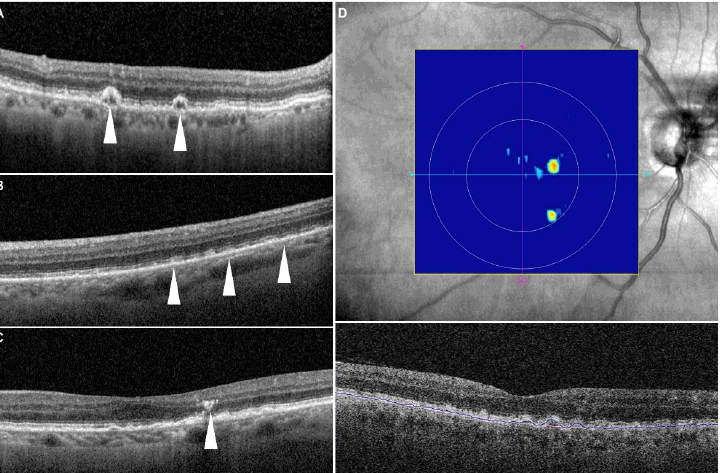
Figure 1. Representative examples of structural optical coherence tomography risk factors. ( A ) Representative examples of structural optical coherence tomography risk Drusenoid lesions with a hyporeflective core (white arrowheads) — note there is no evidence of any shadow artifact to explain the hyporeflectivity; ( B ) subretinal drusenoid deposits (white arrow- heads); ( C ) intraretinal hyperreflective focus (white arrowhead) — here seen above the apex of the drusen; ( D ) drusen volume map from the Cirrus Advanced RPE analysis software — the algorithm segments the RPE band following the RPE contour and also estimates the original RPE position